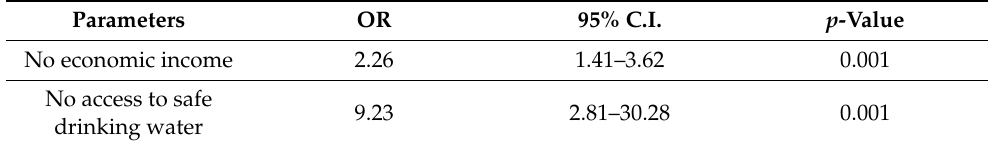
Table 3. Stepwise multiple logistic regression analysis of positive COVID-19 adjusted for social determinants of